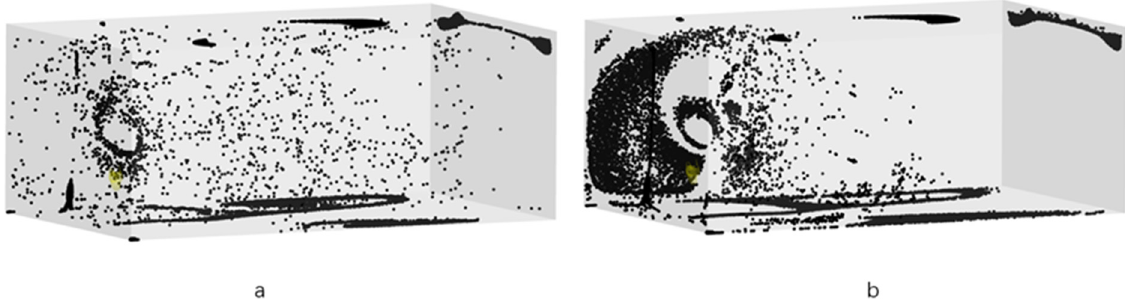
Figure 27. Collision of particles: ( a ) Particle–particle collisions; ( b ) Particle–wall collisions.